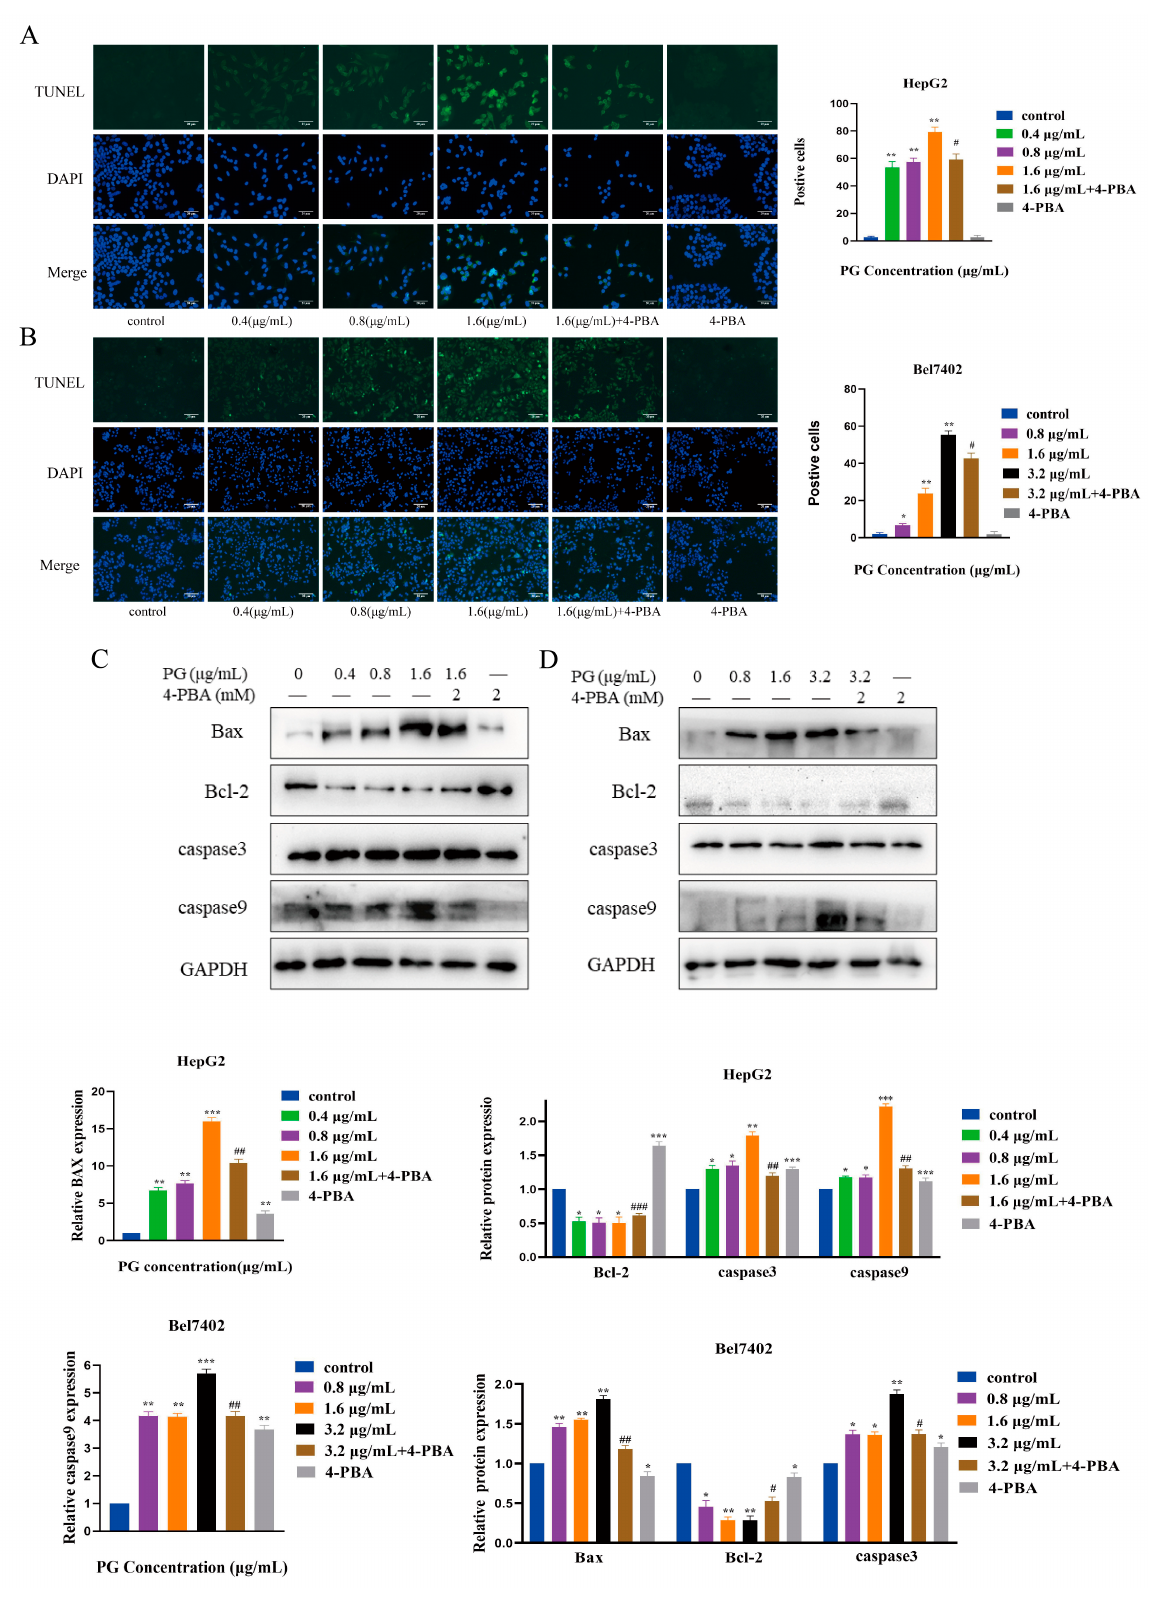
Figure 3. Induction of apoptosis by PG treatment of HCC cells. ( A ). TUNEL assay for the effect of